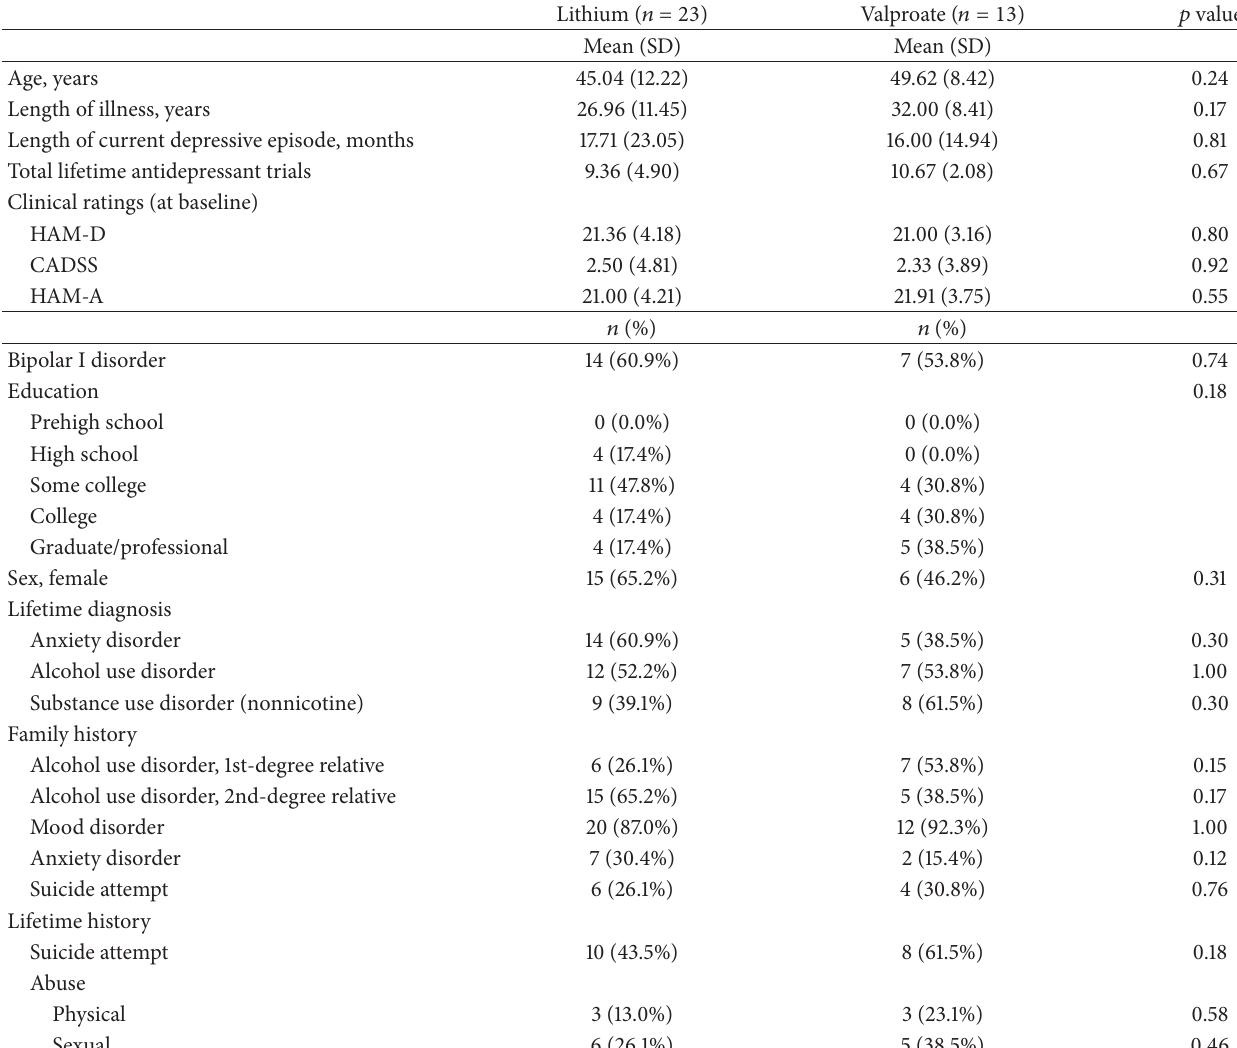
Table 1: Demographic and clinical characteristics of subjects with treatment-resistant bipolar depression maintained on therapeutic dose lithium ( 𝑛 = 23 ) and valproate ( 𝑛 = 13